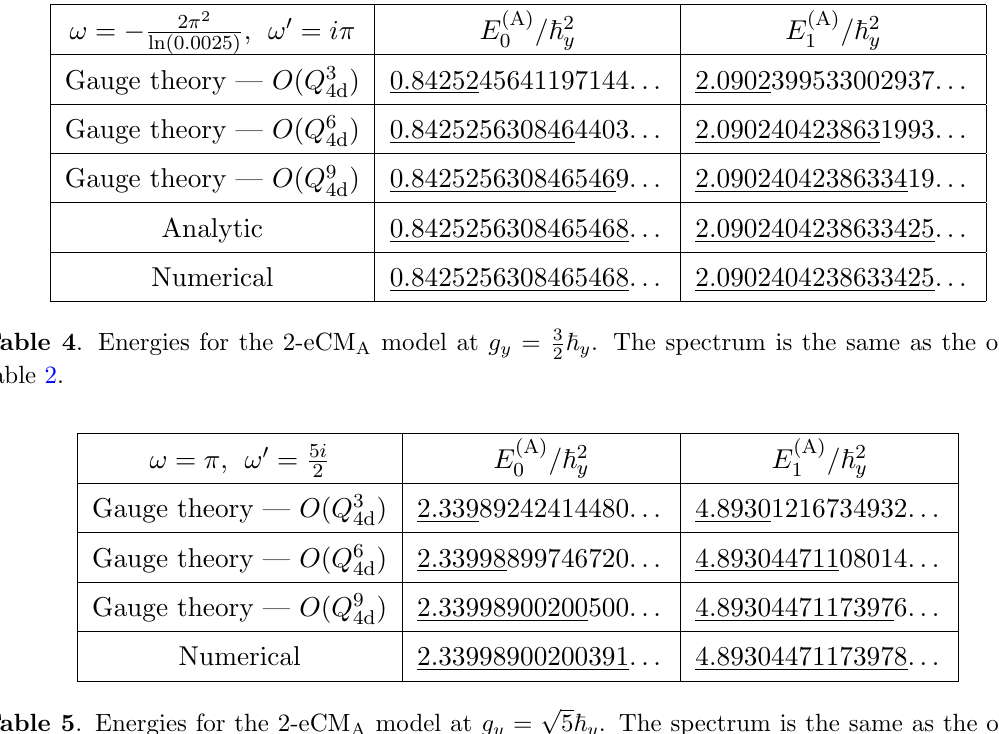
Table 5 . Energies for the 2-eCM A model at g y = table